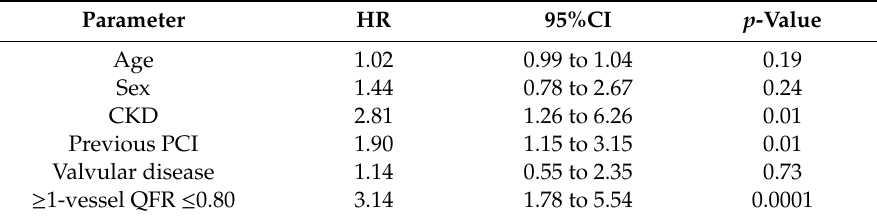
Table 4. Long-term MACCE predictors at multivariate analysis.